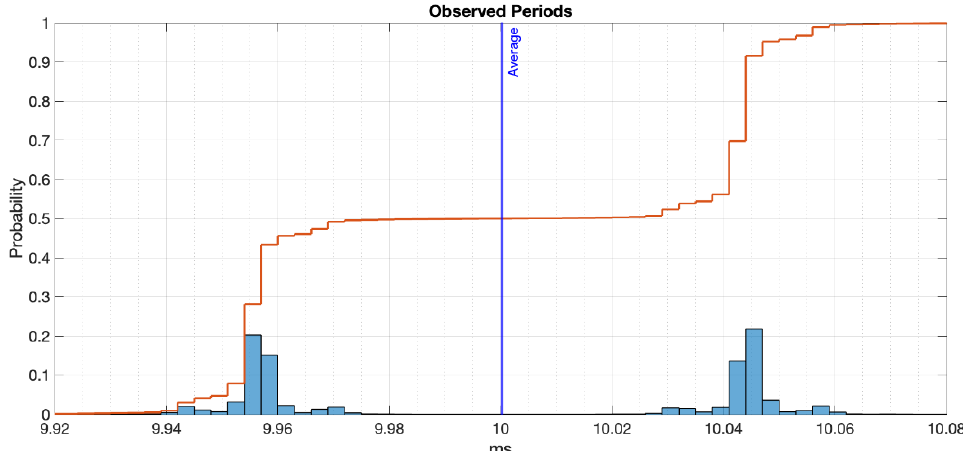
Figure 2. Histogram of the observed periods by the RPi reacting to an external 50 Hz square wave. Converting these values to differences of time with respect to the deterministic values of both the low part and high part of the square signal let us plot an error image of the observed periods. In Figure 3, we depict this fact assuming the average central value for splitting the set of values as the deterministic period. The absolute values of the time drift for both sides of the wave are plotted out as a whole (blue bars) as well as the cumulative probability (red line).